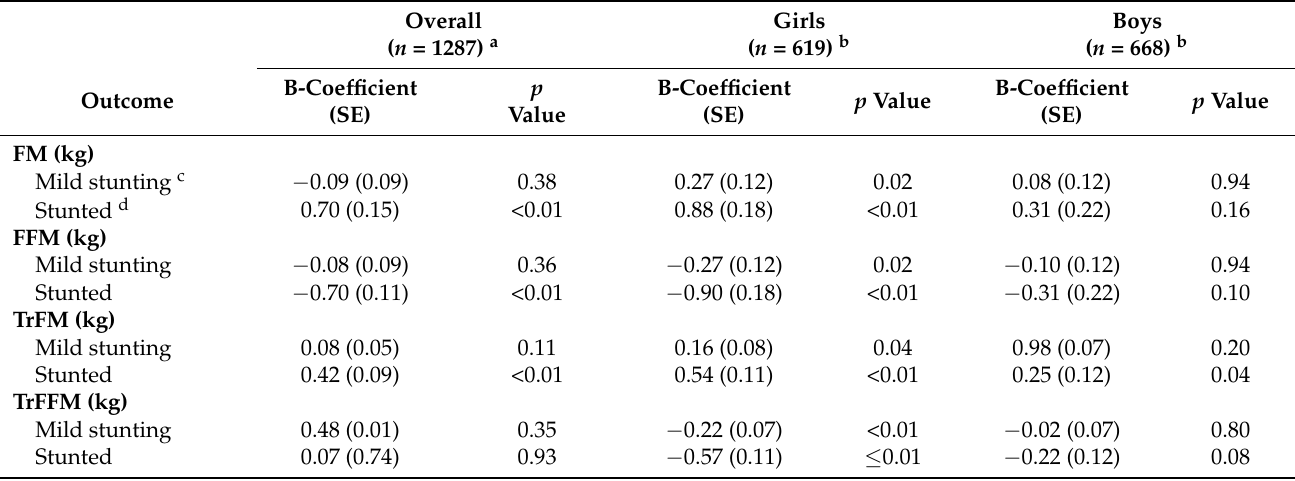
each stunting category but again not among boys. Table 3. Associations of overall and truncal body composition measures with growth impairment among South African school-age children enrolled in the KaziAfya project. Overall Girls Boys ( n = 1287) a ( n = 619) b ( n = 668) b